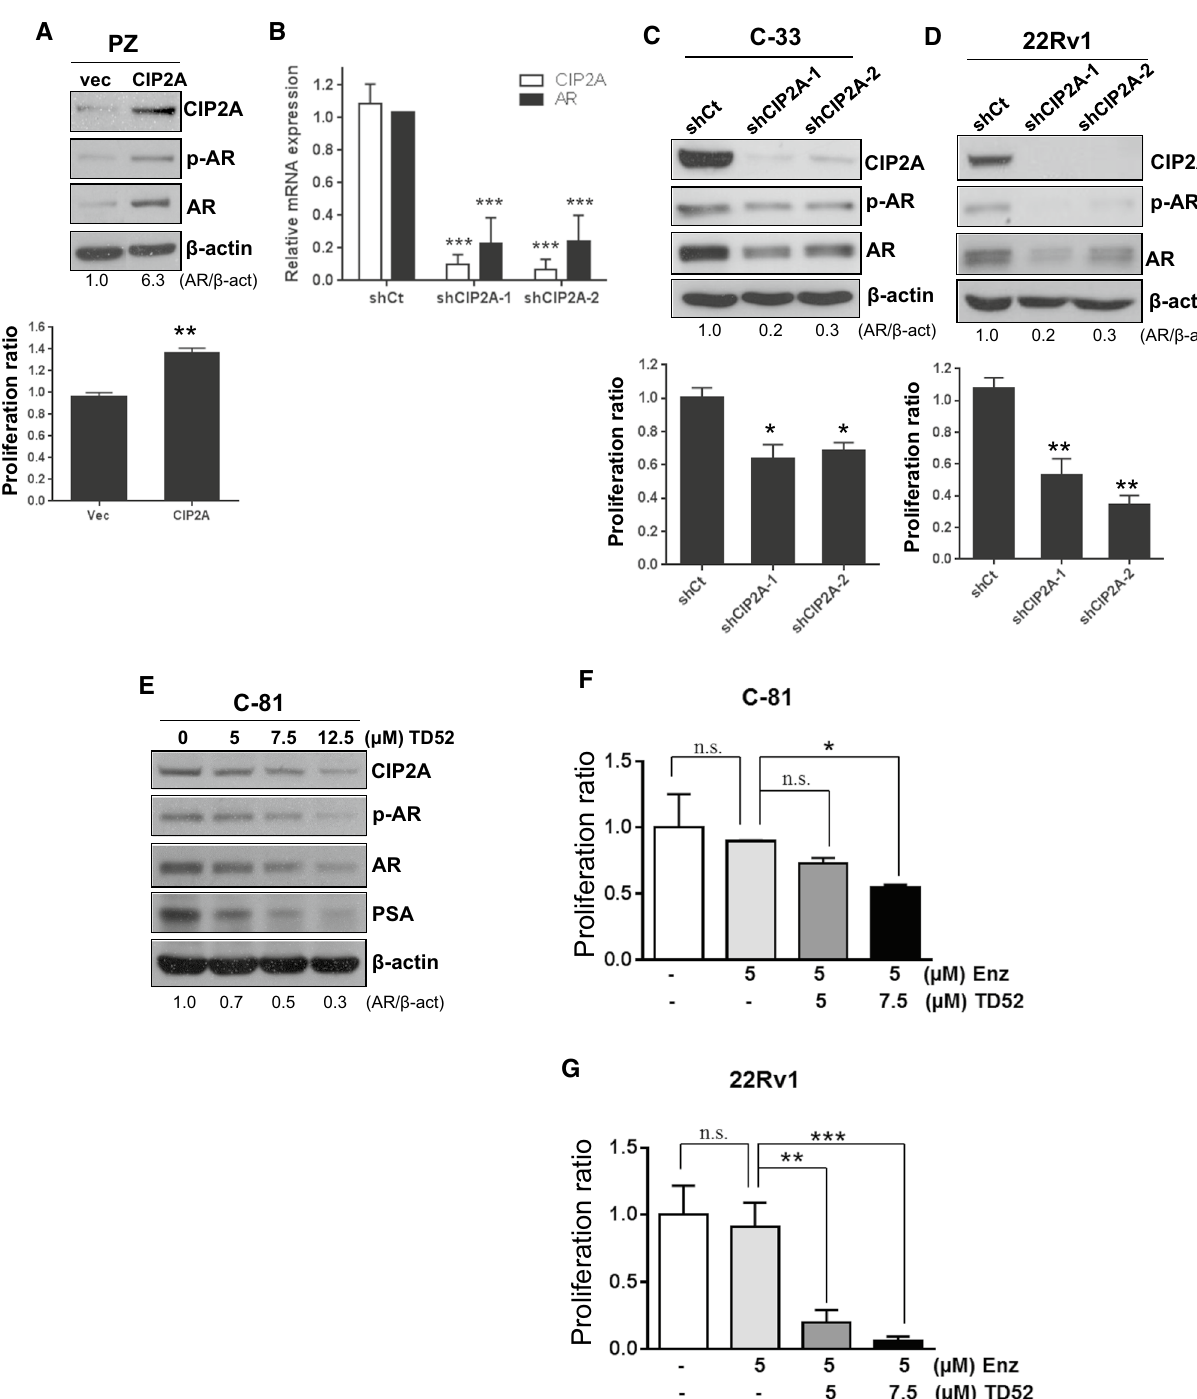
Fig. 3 Effects of CIP2A expression on the AR protein level and proliferation in PCa cells. A The vector-or CIP2A-expressed PZ-HPV-7 (PZ) cells are cultured for western blot analyses (upper panel) and cell proliferation assays (lower panel). B LNCaP C-33 cells are infected with viruses carrying the LacZ - or KIAA1524 -targeted shRNAs (i.e., shCt, shCIP2A-1, or shCIP2A-2). The total lysates are prepared for real-time PCR. C LNCaP C-33 and D 22Rv1 cells infected with viruses carrying the shCt, shCIP2A-1, or shCIP2A shRNA are prepared for western blot analy- ses (upper panel) or cell proliferation assays (lower panel). E LNCaP C-81 cells are incubated with 5 μM, 7.5 μM, or 12.5 μM of TD52 for 24 h. Subsequently, the total lysates are prepared for immunoblotting. The level of AR is quantified using ImageJ software and the relative ratio is normalized to the β-actin level. F C-81 or G 22Rv1 cells are treated without or with 5 μM Enzalutamide (Enz) in the absence or presence of 5 μM or 7.5 μM of TD52. After 72 h of incubation, cells are harvested for cell proliferation assays. Data are expressed as the mean ± SD from three independent experiments. Each set of experiments is conducted in duplicate. *p < 0.05, **p < 0.01 ***p < 0.001 vs. the ratio of the cor- responding control cells. ns not